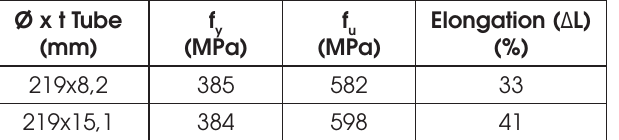
Mechanical properties of steel of tubes